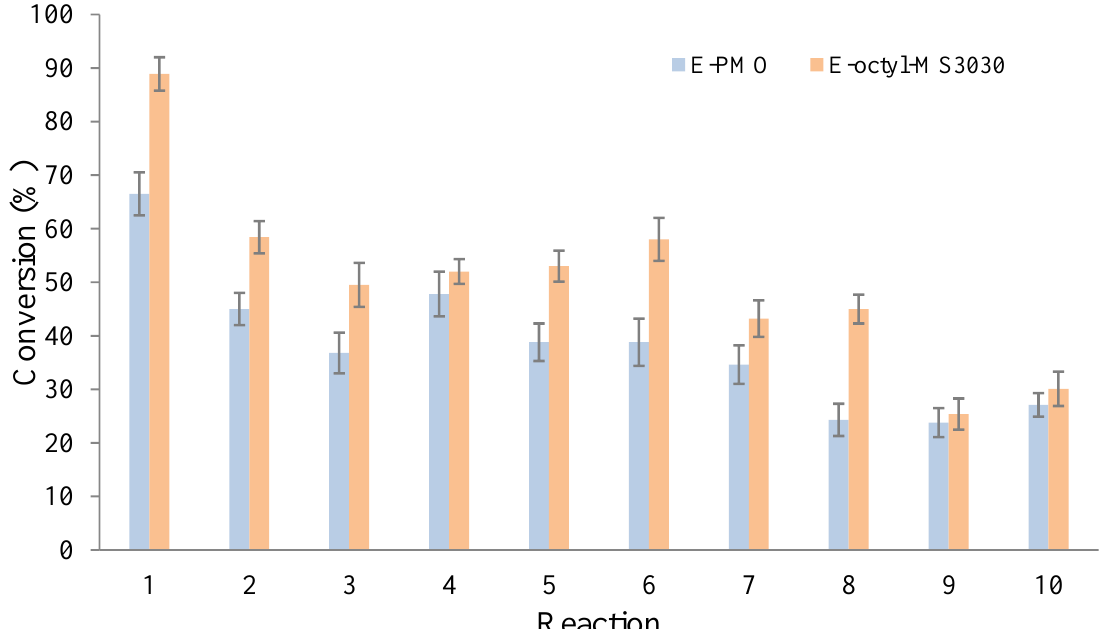
Figure 4. Influence of the catalyst recycling on the biocatalytic activity of E-PMO and E-octyl-MS3030 at 3 h of reaction time. Reaction conditions as in Figure 2.